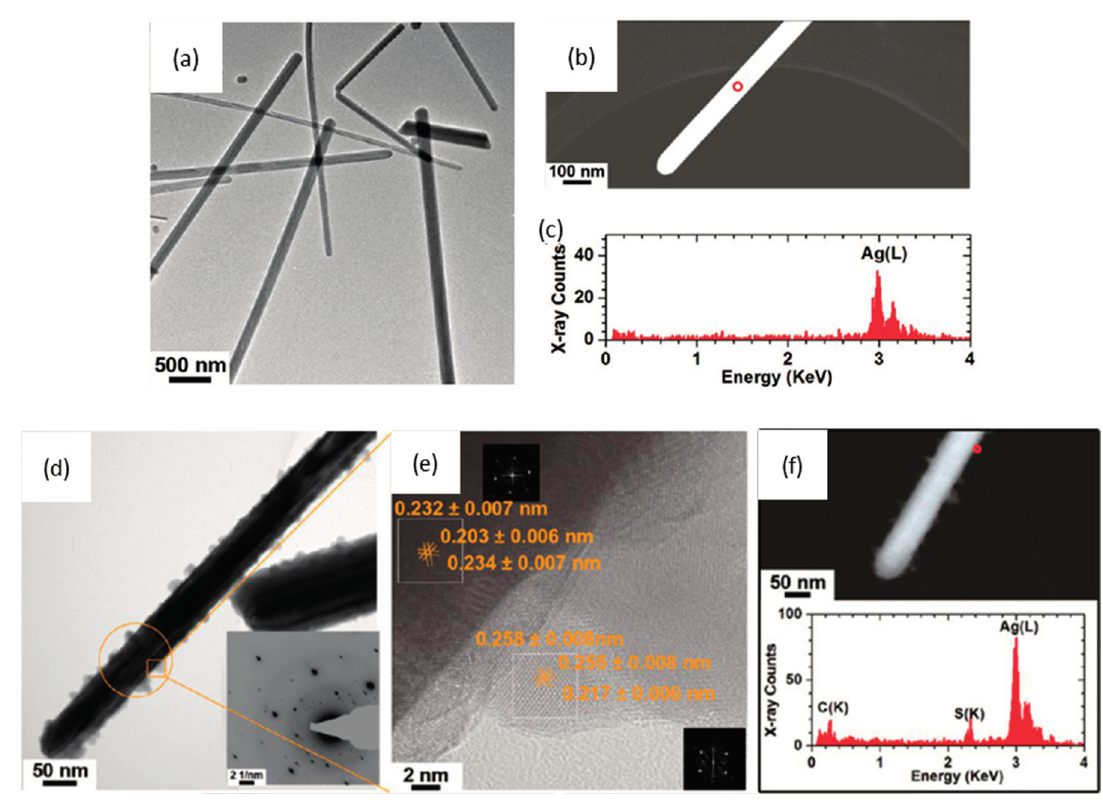
Figure 2. ( a , b ) Low-resolution bright field transmission electron microscopy (BF-TEM) image ( a ) and high angle annular dark field scanning transmission electron microscopy (HAADF-STEM) image ( b ) of as-synthesized silver nanowires (AgNWs); ( c ) The corresponding energy dispersive X-ray (EDX) spectrum collected from the area circled in ( b ); The two peaks at 2.98 and 3.15 keV correspond to the Ag(L α ) and Ag(L β ) peaks, respectively; ( d – h ) Physicochemical characterization of AgNWs incubated in various cell culture media for 1 h at 37 °C; ( d – f ) a high protein serum-free medium (DCCM-1, Biological Industries, Israel); ( g ) Dulbecco’s Modified Eagle Medium (DMEM); and ( h ) Roswell Park Memorial Institute (RPMI-1640) medium; ( d ) Representative BF-TEM image of AgNWs incubated in DCCM-1 medium, showing the formation of crystallites on the surface of the AgNWs. The inset is a selected area electron diffraction (SAED) pattern taken from the circled area (aperture size ~130 nm); ( e ) HRTEM image collected from the boxed area in ( d ) reveals that the crystallites have a different crystal structure than the original AgNWs. The lattice spacings of the crystals formed at the surface of the AgNWs (~0.26 and 0.22 nm) correspond to the (112) and (031) lattice spacings of Ag 2 S, respectively. The lattice spacings of the core of the nanowires (~0.23 and 0.20 nm) correspond to the interplanar spacings of metallic Ag. Insets are fast Fourier transform (FFT) patterns taken from the two-boxed areas; ( f ) HAADF-STEM image (top) taken from the same area as ( d ) and STEM-EDX spectra collected from the circled area (bottom), confirming the formation of Ag 2 S; ( g , h ) HAADF-STEM images (top) and EDX spectra (bottom) of AgNWs incubated in DMEM ( g ) and RPMI-1640 ( h ) cell media, indicating that AgNWs do not sulphidise in DMEM or RPMI-1640. Adapted with permission from [143]. Copyright 2013 American Chemical